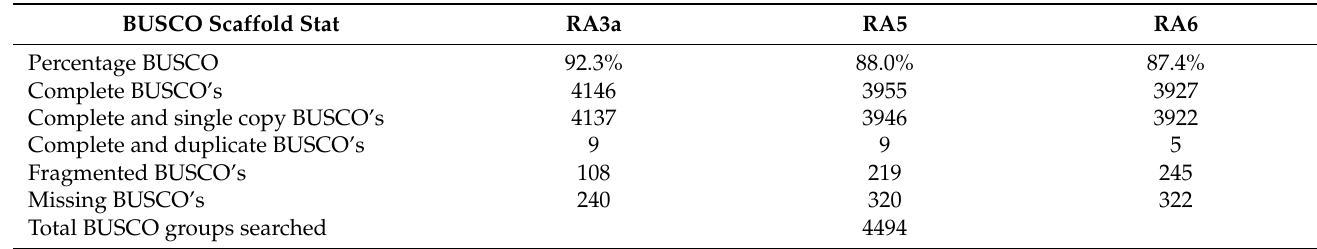
Table 6. Proteins BUSCO: dataset Hypocreales_odb10 for the predicted proteomes of the fungal isolates RA3a, RA5, and